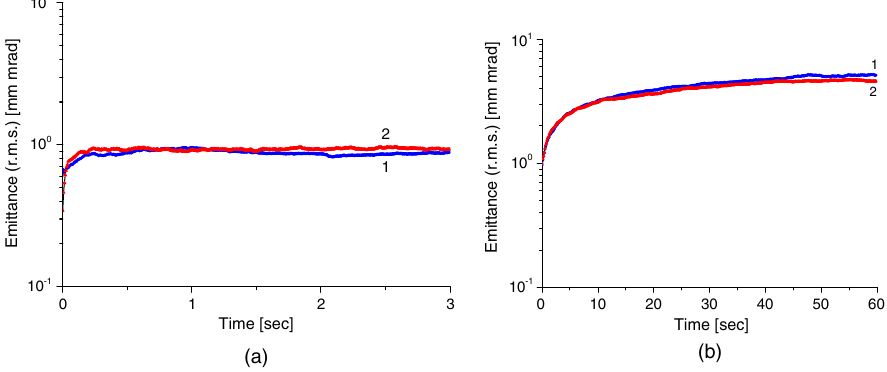
FIG. 5. Evolution of rms emittance in ELISA in horizontal (blue) and vertical (red) planes: (a) Mg þ beam grows to the ring acceptance of A ¼ 6 (cid:4) mm mrad in the first 200 ms after injection, such fast growth was observed in ELISA; (b) assuming a ring acceptance as large as A ¼ 50 (cid:4) mm mrad the emittance of the O (cid:3) beam should grow steadily in (cid:8) 50 s which contradicts ELISA measurements. FWHM ¼ 3 : 43 mm was measured at the point where the horizontal beta function is equal to (cid:1) x ¼ 3 : 5 m [Fig. 4(b)].